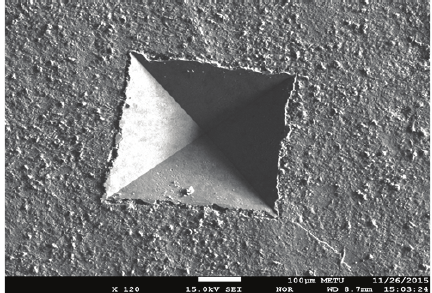
Figure 12: A crack initiated from the corner of a Vickers indent for a 5BHA composite sintered at 1300 ∘ C.